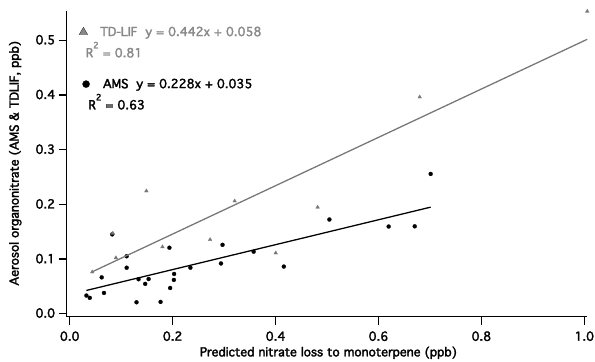
Figure 5. Sample calculation of ( NO 3 , loss ) integ overlaid against aerosol RONO 2 measured by AMS (red). The monoterpene max- ima correlate well with the AMS maxima (black dots). Minima and maxima (black dots) were chosen for the beginning and end of AMS buildup periods, respectively. The time period shown is arbitrarily chosen.